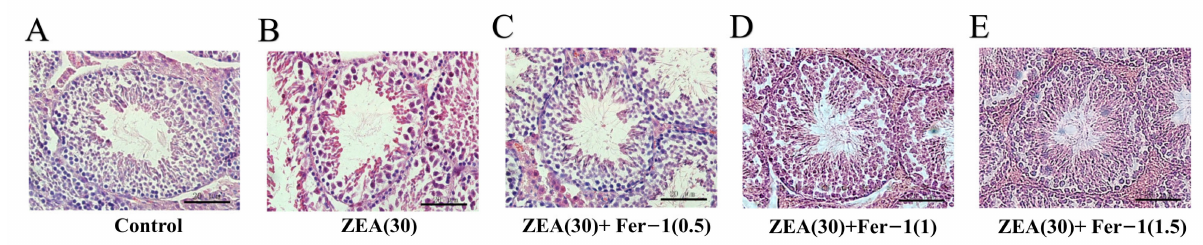
Figure 2. Seminiferous tubule architecture in hematoxylin eosin (H&E) stained sections in the testes of experimental mice. (Scale bar = 20 µ